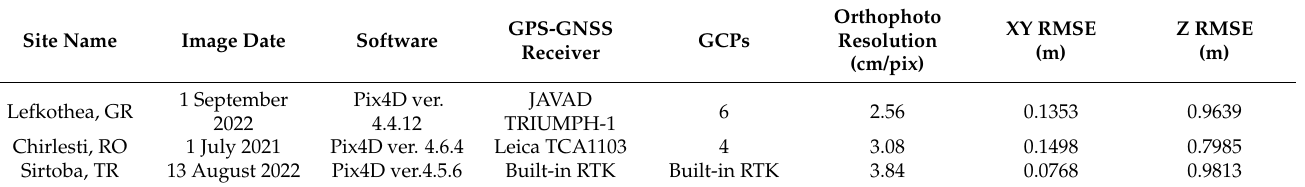
Table 2. The root-mean-square error (RMSE) of the orthophotos (XY) and DSMs (Z) generated with Pix4DMapper during the photogrammetric process using the available